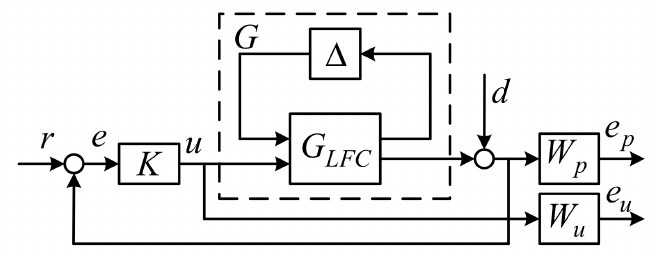
Figure 4. Closed-loop system structure.